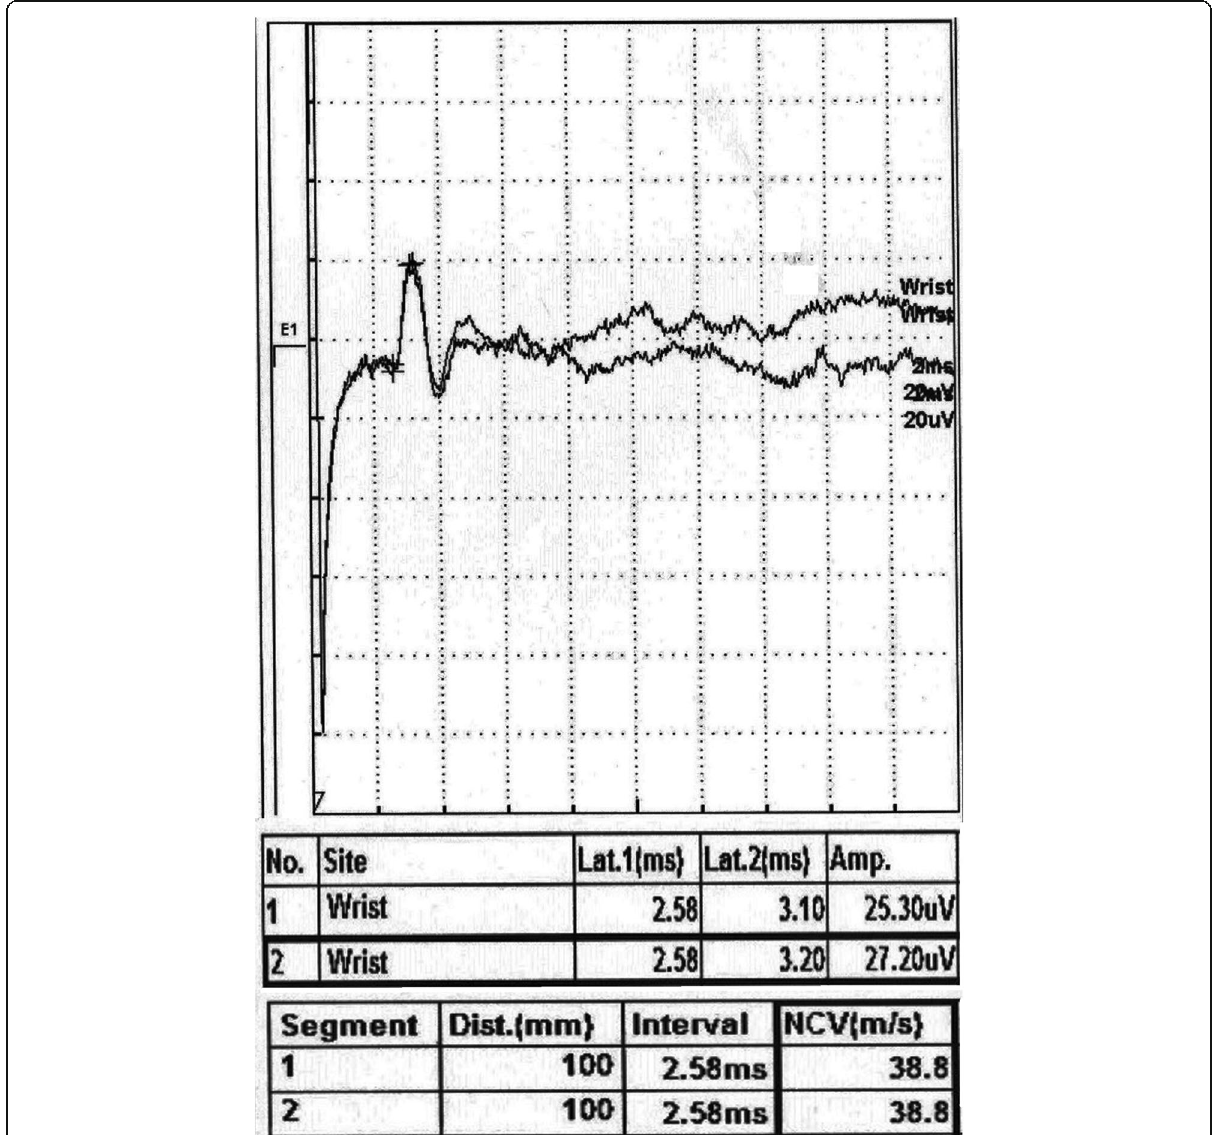
Fig. 6 Sample tracings show the superficial radial nerve sensory nerve action potentials of a patient with superficial radial